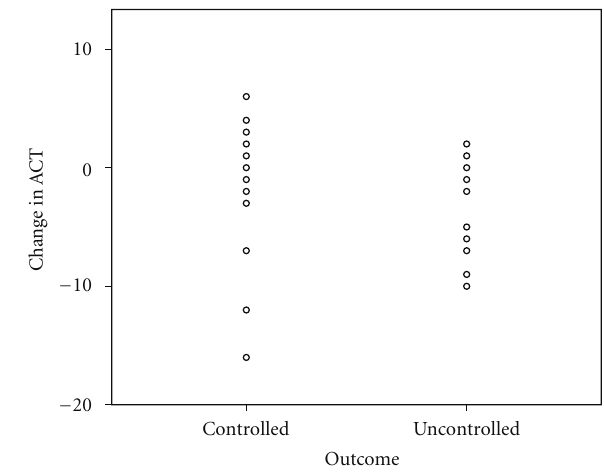
Figure 3: Scatterplot showing patient’s change in ACT score comparing those that maintained asthma control o ff LABA therapy at followup (controlled) and those that experienced loss of asthma control